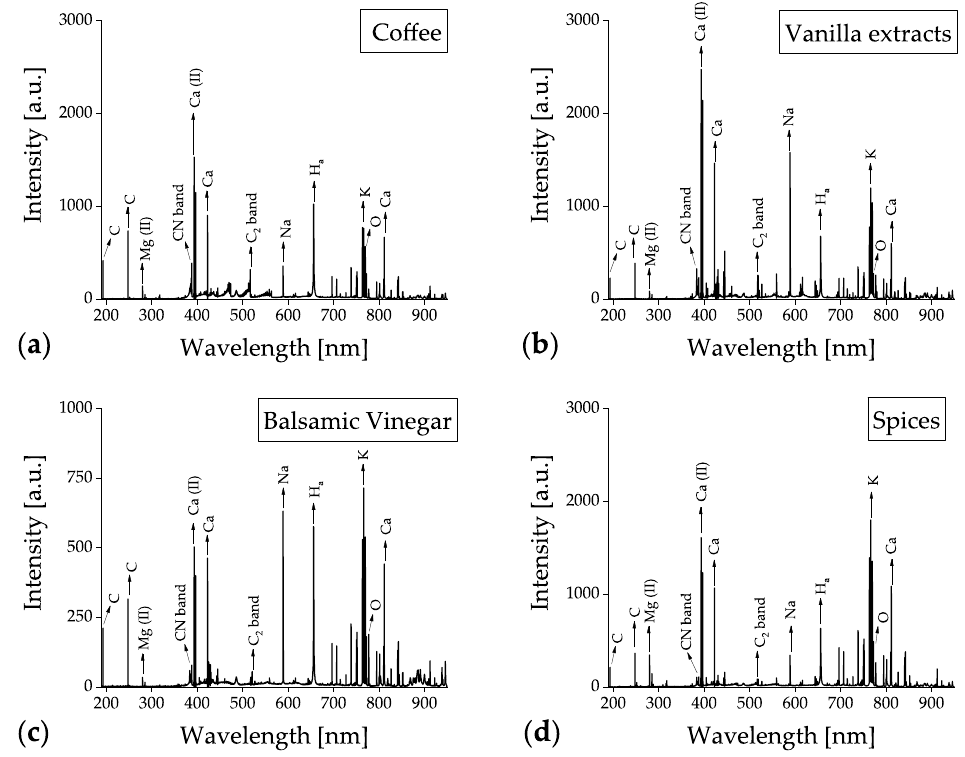
Figure 5. Averaged raw LIBS spectra of ( a ) coffee, ( b ) vanilla extract, ( c ) balsamic vinegar, and ( d ) spice samples collected using the handheld LIBS system.